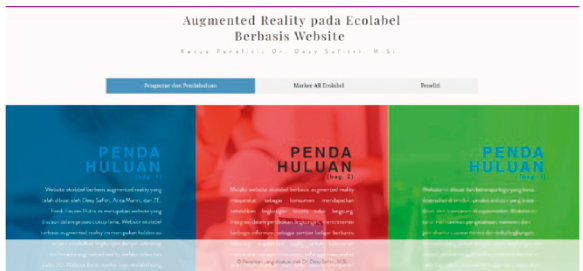
Figure 1: Homepage of web-based augmented reality.